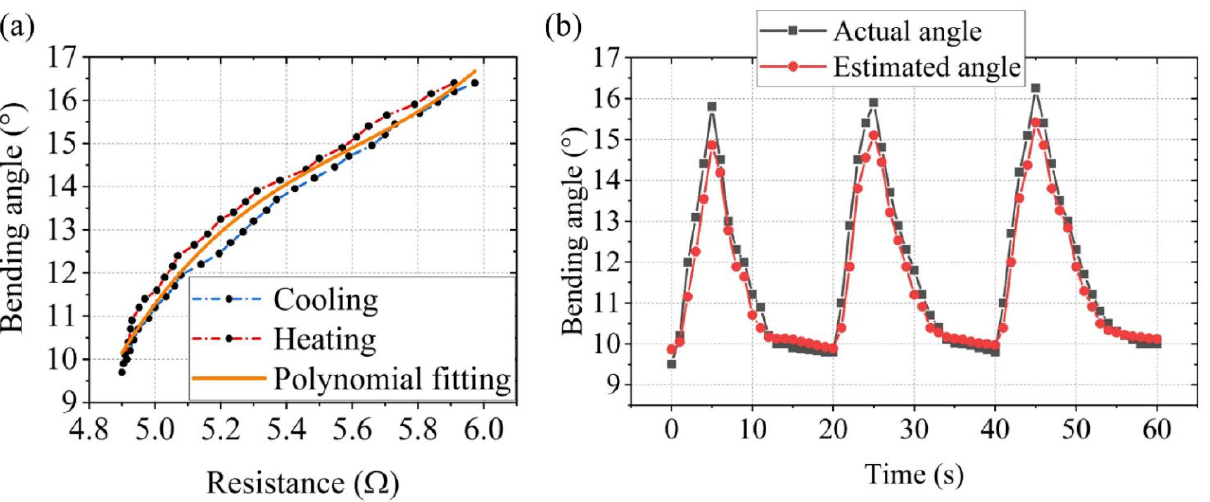
Table 2. Identified parameters of the third-order polynomials.